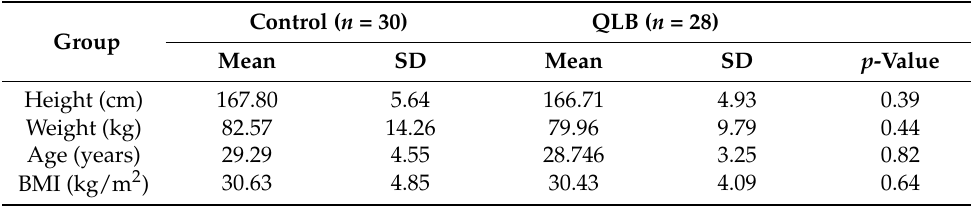
Table 1. Patient demographics. Height, weight, age, and BMI are presented as mean and standard deviations (SD). The groups did not differ in terms of demographic data. Previously published in Mieszkowski et al. Evaluation of the effectiveness of the quadratus lumborum block type I using ropivacaine in postoperative analgesia after a cesarean section—a controlled clinical study ( Ginekol. Pol. 2018 , 89 (2), 89–96) [11].